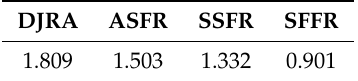
Table 5. Edge-user date rate numerical analysis